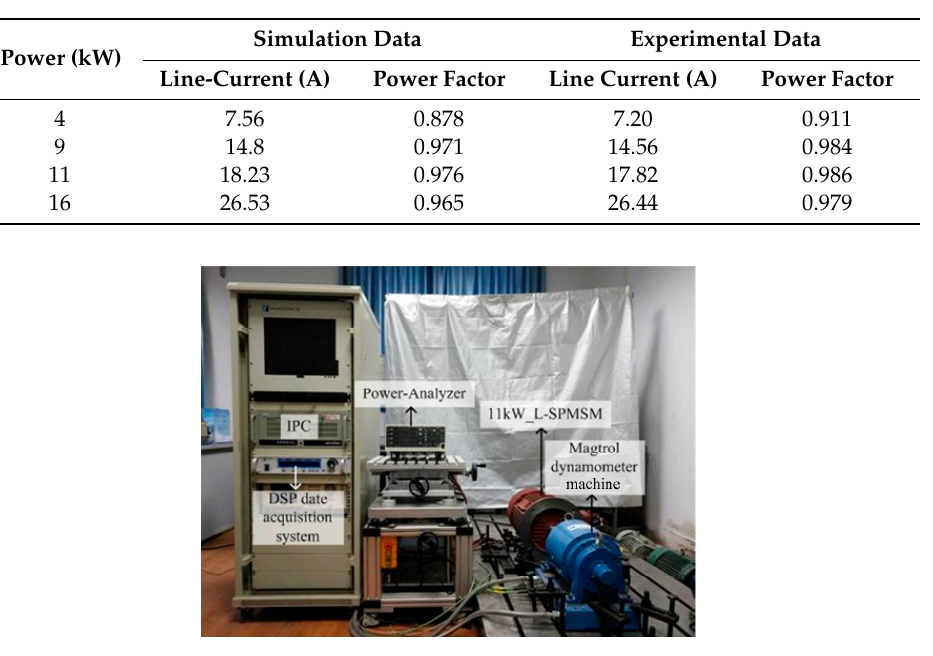
Table 2. Simulation and experimental data.